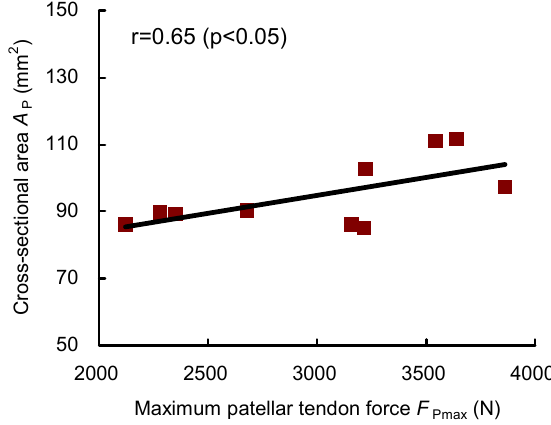
Fig. 6 Relationship between the patellar tendon cross-sectional area and the maximum patellar tendon force.